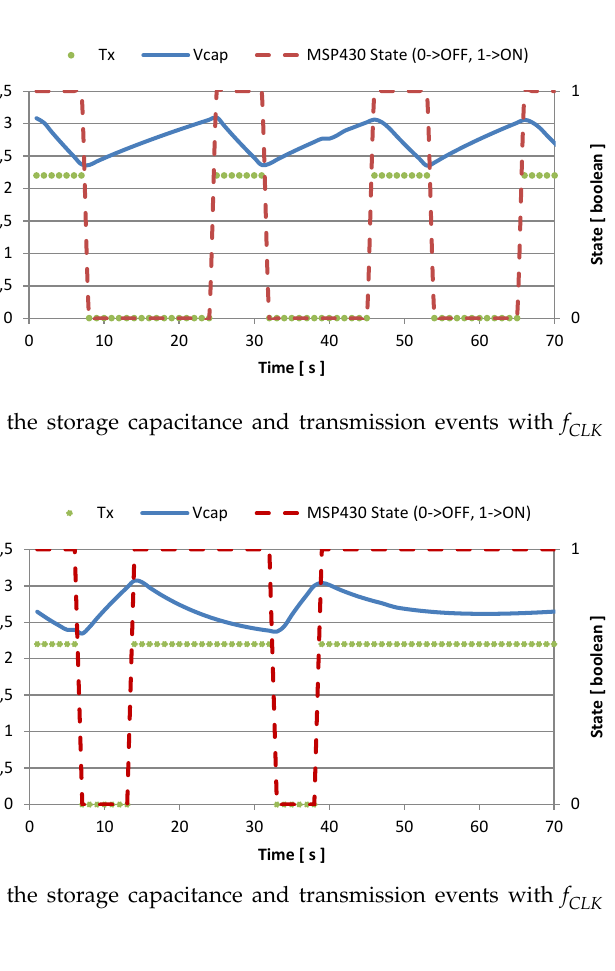
Figure 8. Voltage in the storage capacitance and transmission events with f CPU load =